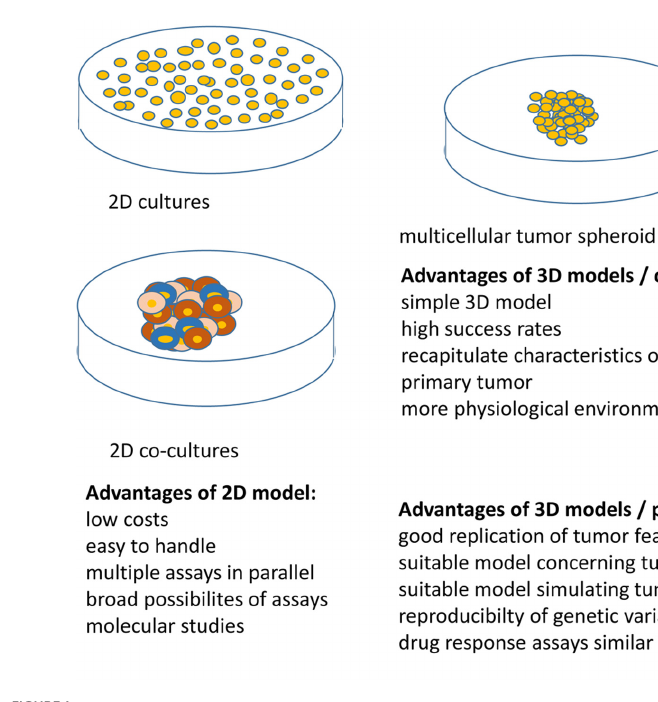
FIGURE1 Distinct in vitro models for monitoring treatment